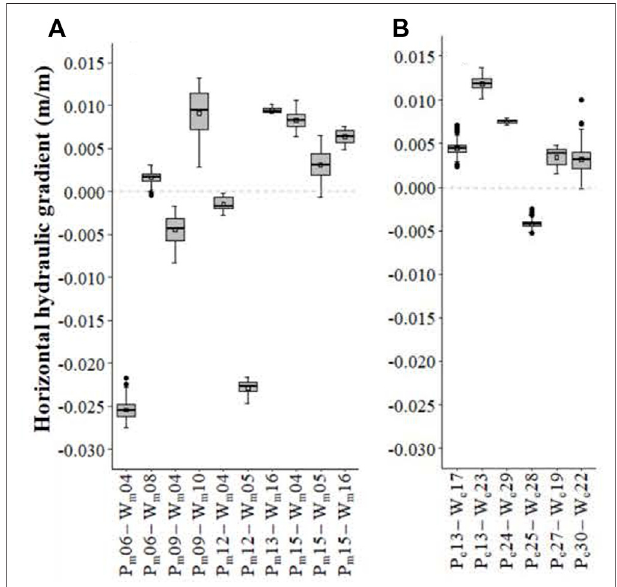
FIGURE 6 | Horizontal hydraulic gradient between stations used in the Darcy fl ow calculation for (A) the Misask peatland and (B) the Cheinu peatland. Positive values indicate fl ow from the aquifer to the peatland and negative values indicate fl ow from the peatland to the aquifer. Squares indicate mean values.